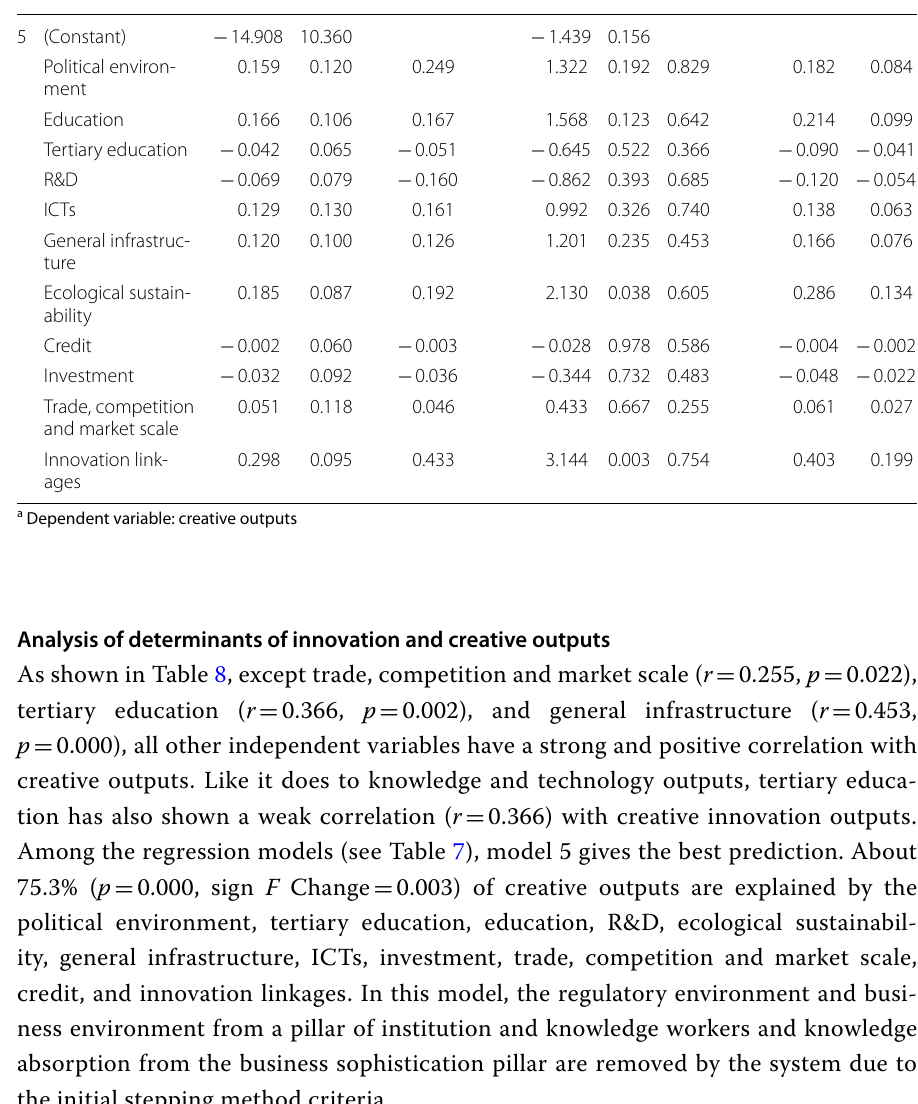
Table 8 and Additional file 1: Table S8). At a pillar level, creative outputs strongly cor- relate with infrastructure ( r